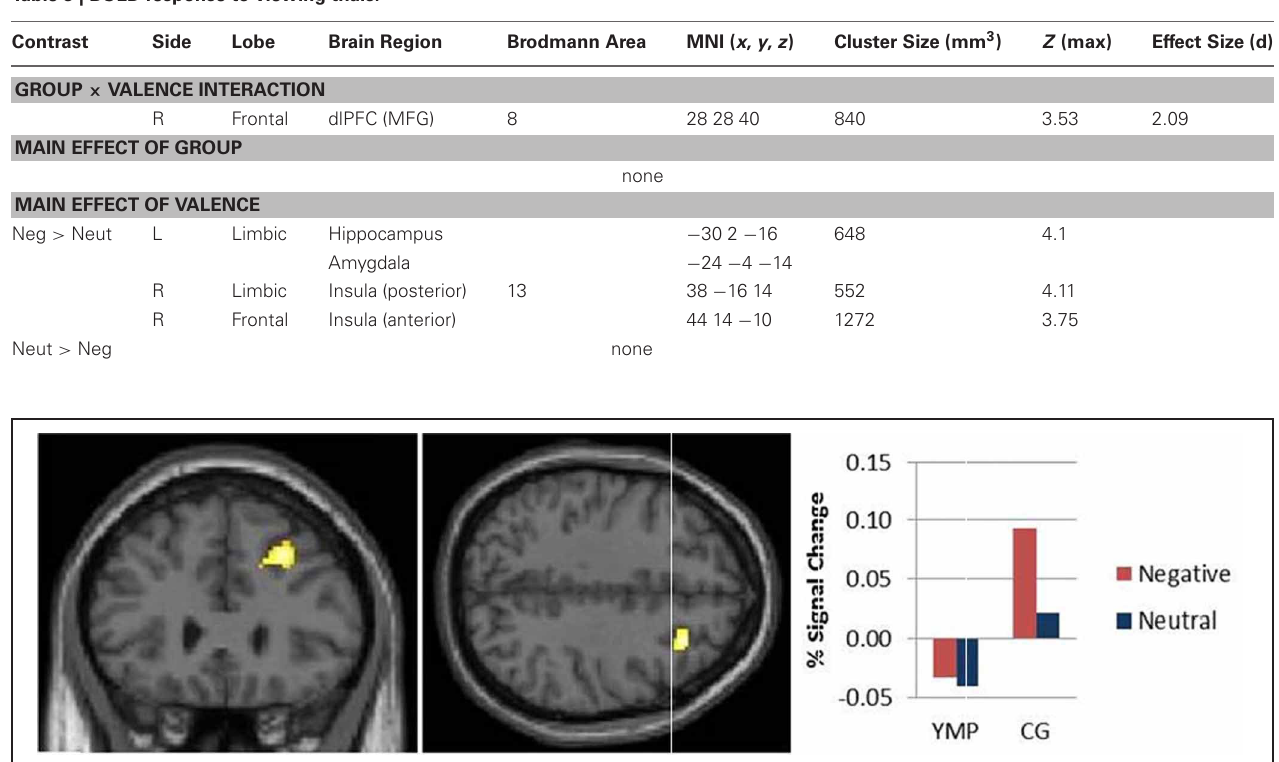
EXPLORATORY ANALYSIS OF SELF-REPORTED AFFECT